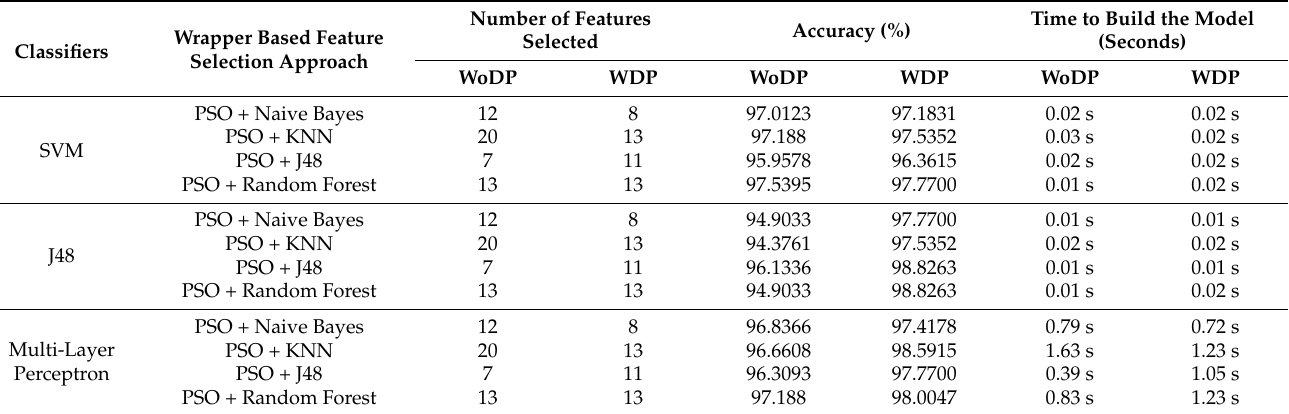
Table 4. Accuracy comparison of classifiers on data with genetic search feature selection.